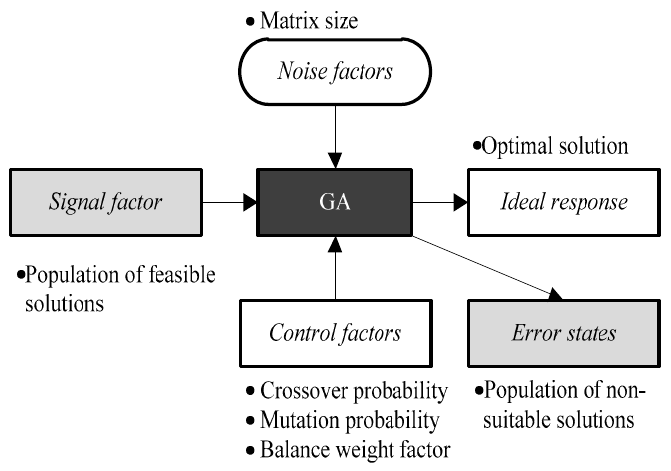
Figure 2. Parameter diagram for a genetic algorithm. Table 1. Input signal factors and